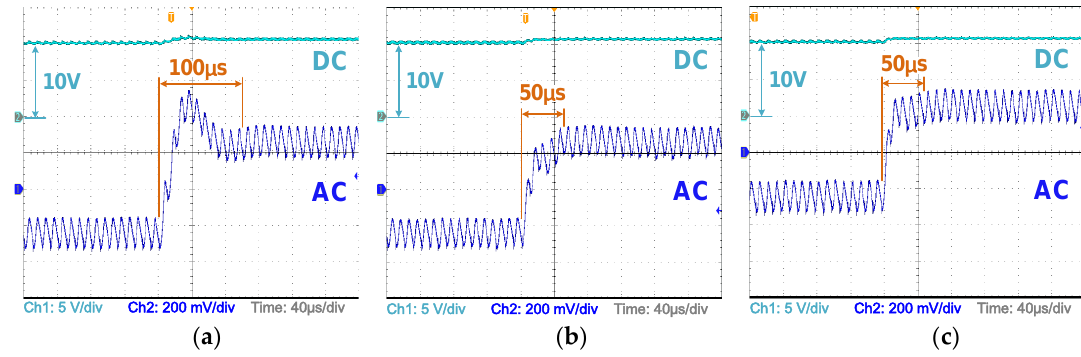
Figure 16. Output voltage transient responses when the reference voltage steps from 10 V to 10.5 V ( a ) PI control ( b ) discrete charge balance (DCB) control ( c ) linearized discrete charge balance (LDCB) control.